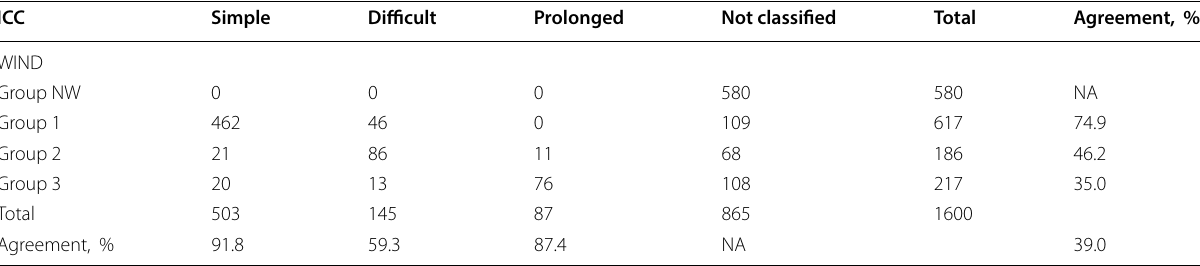
For each line and column, agreement was calculated as follows: (number of patients classified in the same group by 2 classifications)/(total number of patients in line or column) ICC International Consensus Conference, WIND Weaning according to a New Definition, NW no weaning, NA not accessible